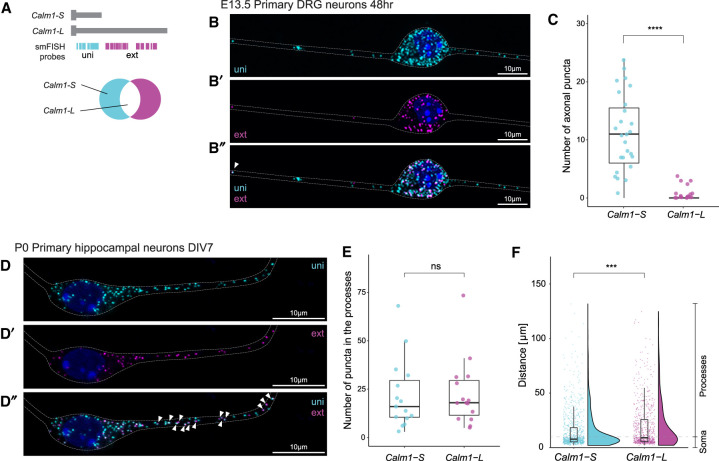
Subcellular localization of Calm1-L. (A) Diagram showing RNAscope smFISH probe locations. When uni and ext images are merged, Calm1-L isoforms are shown as colocalized (white) puncta. (B) smFISH showed robust axonal localization of Calm1-S (uni), but Calm1-L (ext/magenta in B′ or white punta in B″) was observed in DRG axons. (C) When the number of axonal uni or ext puncta was counted, uni signals were robustly found in the axons of DRG neurons but little to no ext signals were found in the same regions. Significance was determined using a t-test, (****) P < =0.0001. n = 30 neurons. (D) In primary hippocampal neurons, both Calm1-S and Calm1-L were observed in soma and neuronal processes. (E) The number of puncta corresponding to Calm1-S and Calm1-L transcript in the hippocampal processes was not found to be significantly different. Significance was determined using a t-test, ns: P > 0.05. n = 15 neurons. (F) Analysis of the distance of travel for all the Calm1-S and Calm1-L signals showed the overall distribution is different between two mRNA isoforms. Analysis done in n = 15 neurons (Calm1-L 684 puncta, Calm1-S 907 puncta). Significance was determined using a Wilcoxon test, (***) P < =0.001.